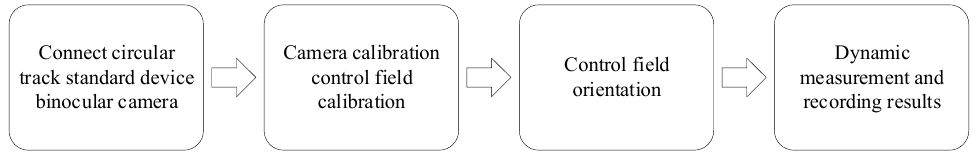
Figure 7. Experimental procedure.